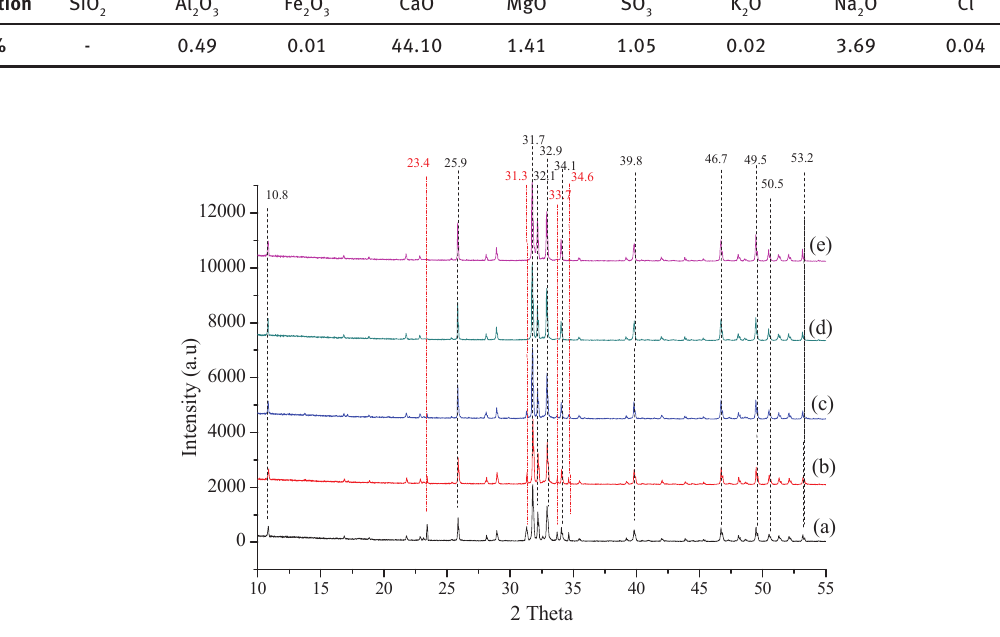
PO : (a) 0 M, (b) 25 mM, (c) 30 mM, (d) 35 mM, and 3 4 PO = 1 g/10 mL, reaction temperature 80°C, pH 11 and calcine temperature 900°C. 3 4